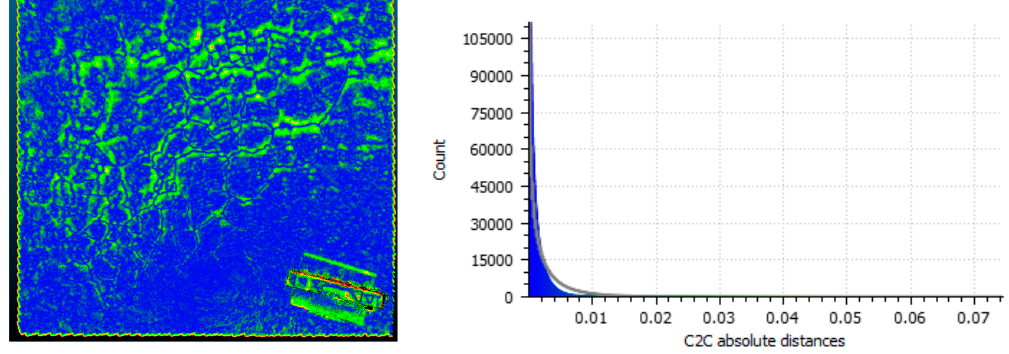
Figure 18. Measured differences between model generated by the camera and Huawei phone, ( right )—visualization of differences projected on model, ( left )—distribution of measured differences.